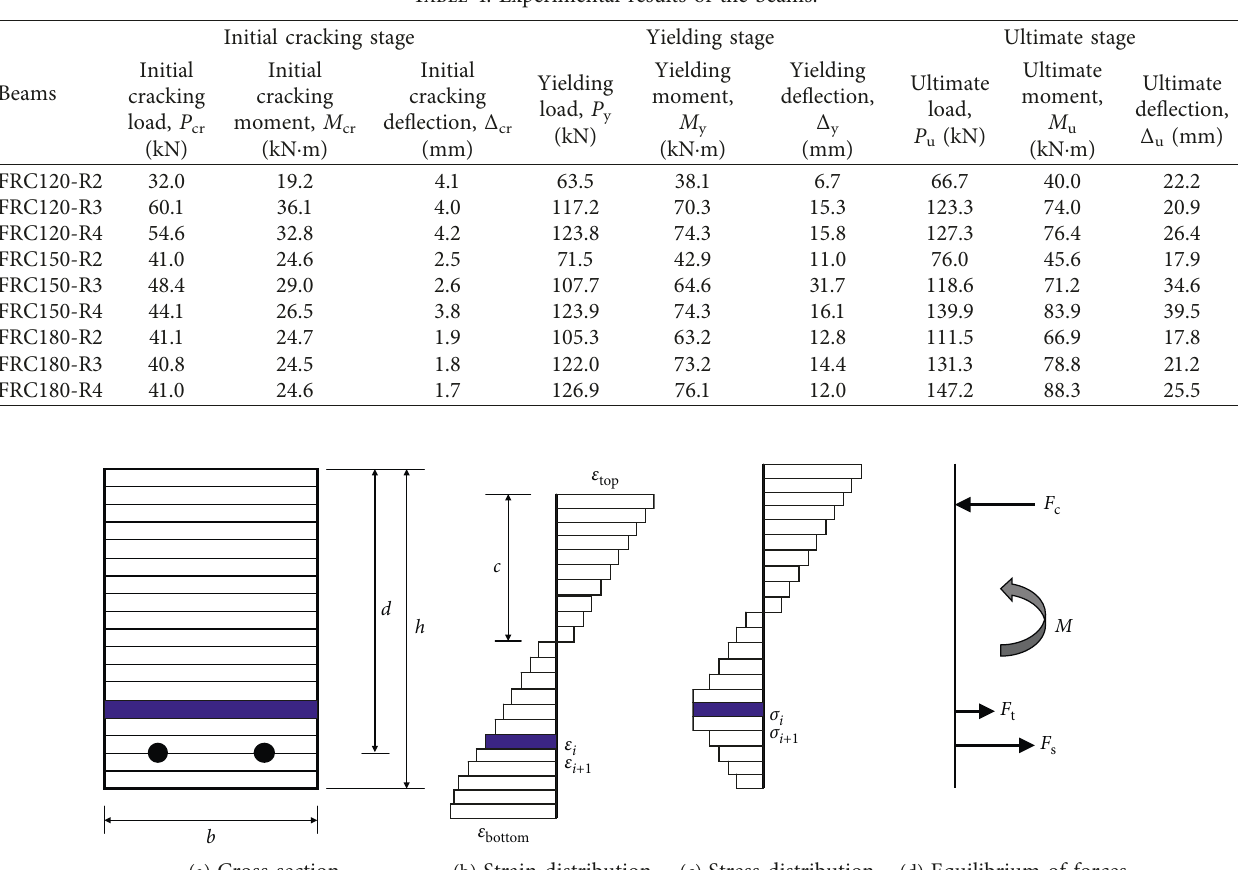
Table 4: Experimental results of the beams.